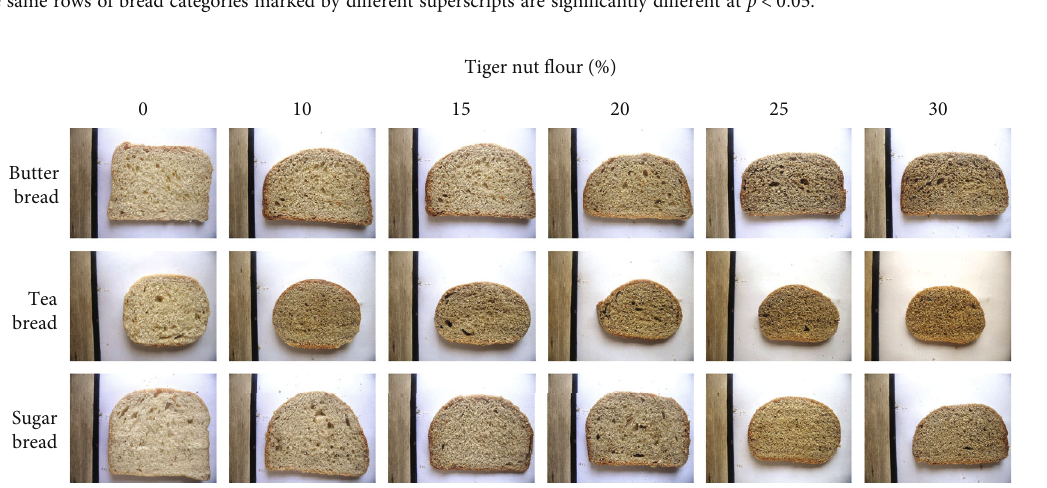
Figure 1: Cross-sections of butter bread, tea bread, and sugar bread produced by partial substitution of wheat fl our with tiger nut fl our. Numbers refer to percentage tiger nut fl our